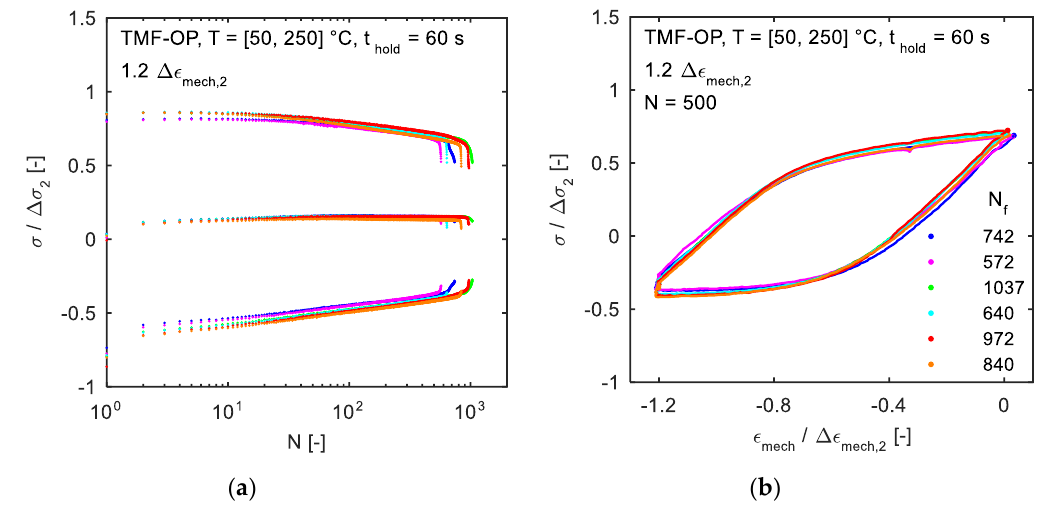
Figure 6. Performed TMF tests with Δε mech = 1.2 Δε mech,2 and T max = 250 °C: ( a ) Cyclic hardening-softening curves; ( b ) Stress–strain hystereses of cycle N = 500.